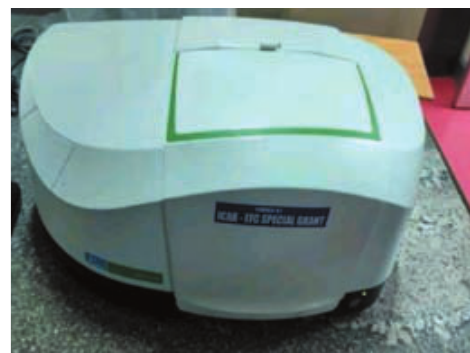
Fig-4 Perkin Elmer Spectrum 2